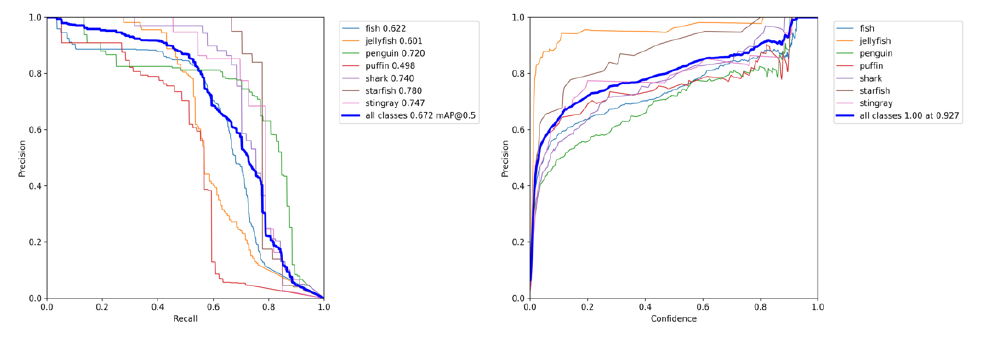
Figure 14. PR-curve and R-curve.